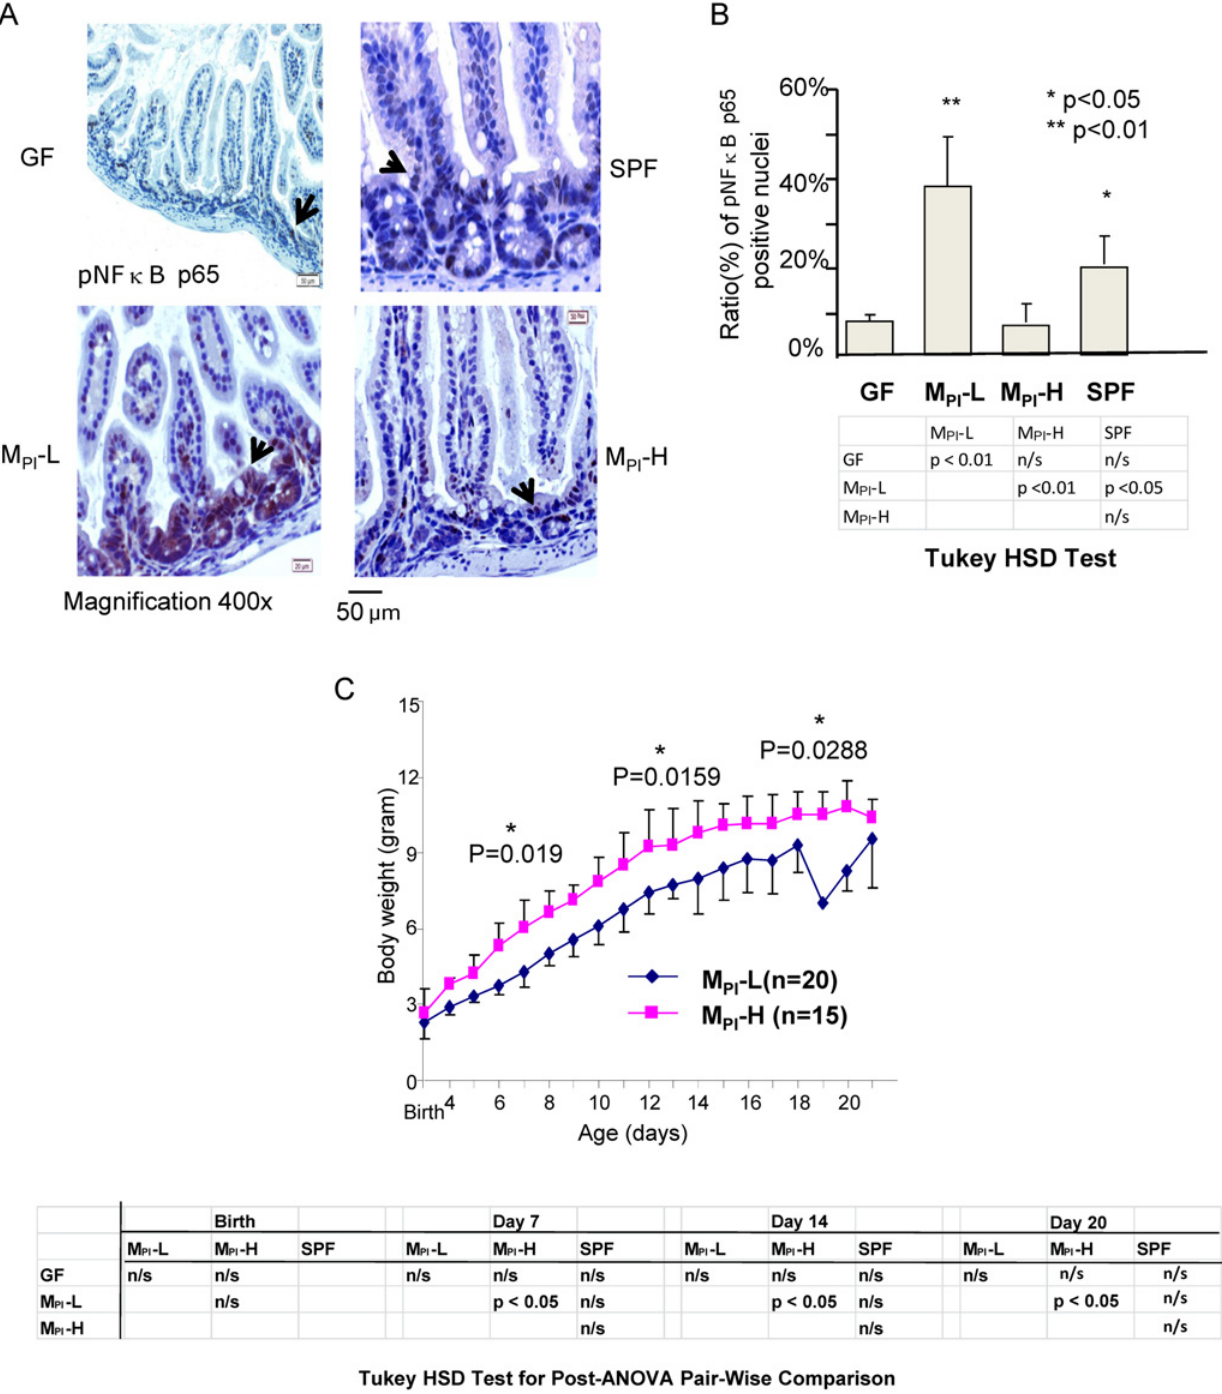
Fig 6. NF- κ B activation in M PI -L, -H and SPF GF ileum mucosa by immunohistochemistry. A: NF- κ B activation was analyzed by immunohistochemical staining of 5 micron paraffin-embedded distal ileum tissue from GF, M PI -L, H and SPF mouse. Representative areas (n = 3/per group) are shown (magnification 400x), black arrows indicate nuclear translocation of the phosphorylated NF- κ B p65 subunit. B: Nuclear translocation of pp65 was quantified by ImmunoRatio tool from Image J software and presented as % of pp65 positive nuclei/total nuclei. C: Growth curve of M PI -L (n = 20) and M PI -H (n = 15) from birth to weaning. One-way ANOVA with post-hoc Tukey ’ s HSD test was used to compare the groups.